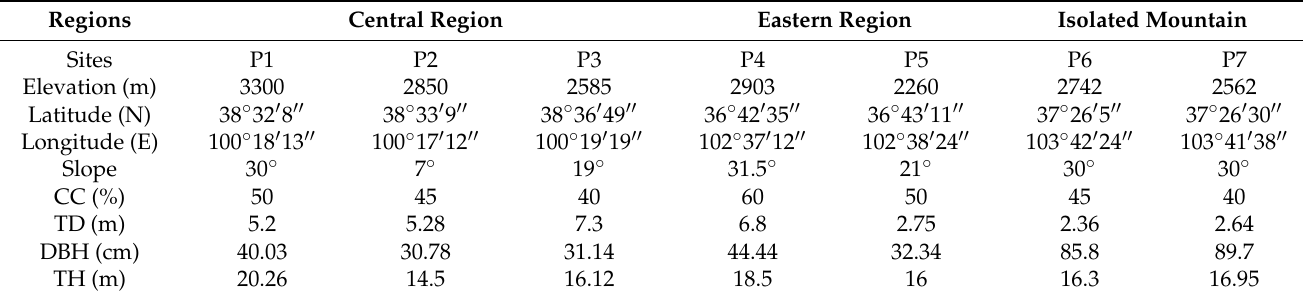
Table 1. Information about the sampling sites of the Qinghai